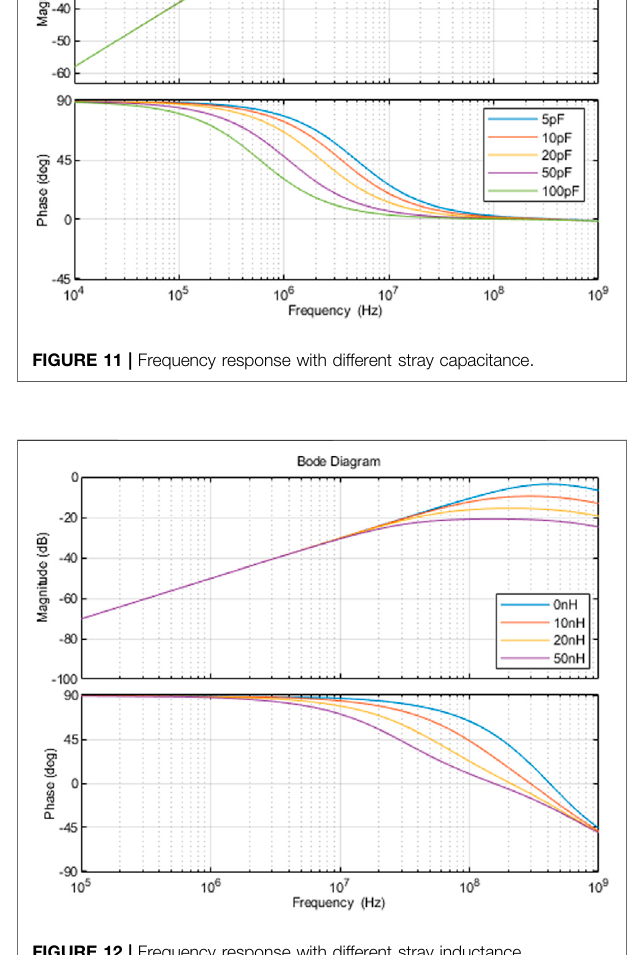
FIGURE 14 | Effect of C 2 on sensor detection